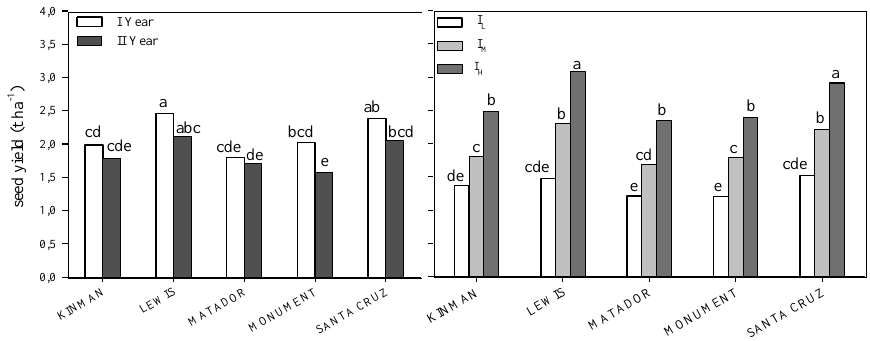
Figure 2. Seed yield (t ha − 1) among guar cultivars in the two years of the experiment, averaging water Figure 2 . Seed yield (t ha−1) among guar cultivars in the two years of the experiment, averaging water regimes (left), and in the three levels of irrigation, averaging the regimes ( left ), and in the three levels of irrigation, averaging the two-year results ( right ). Within each two-year results (right). Within each box, bars with different letters differ for p < 0.05. box, bars with di ff erent letters di ff er for p < 0.05.